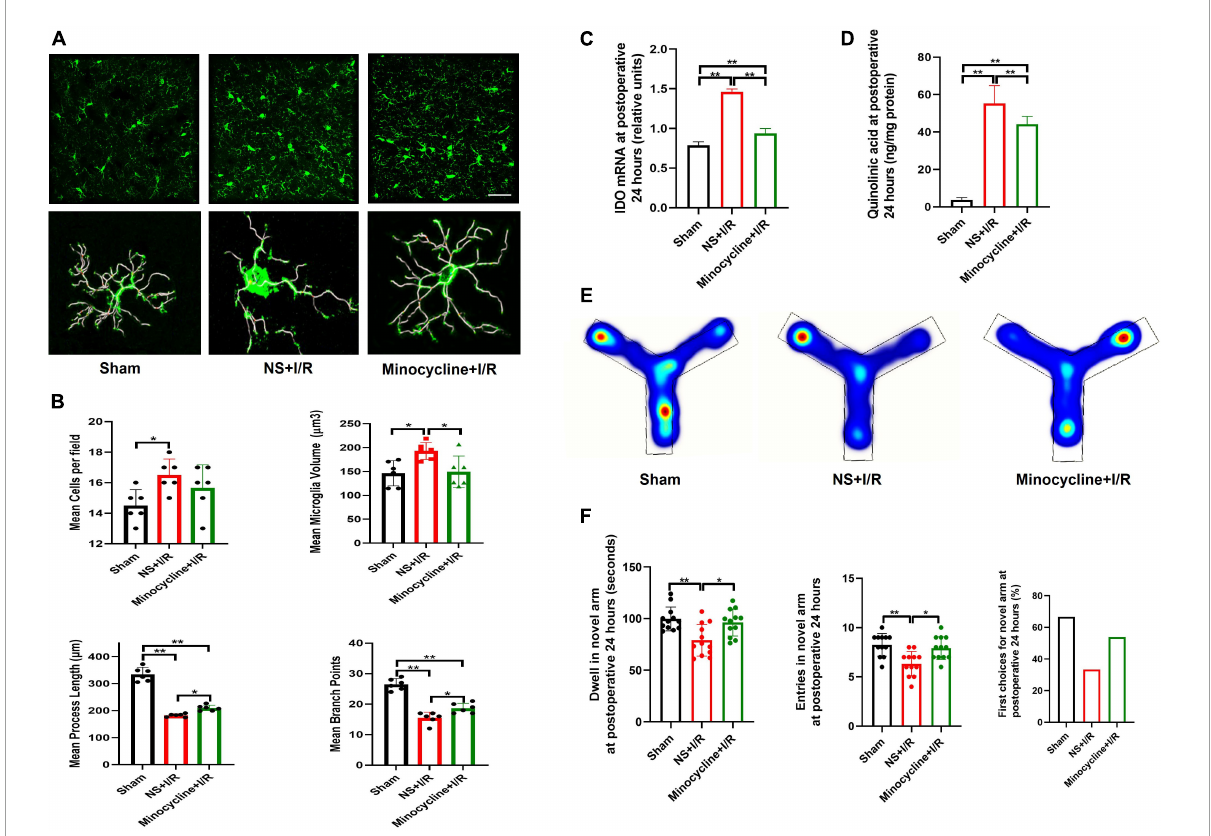
FIGURE4 Microglia reactivation and IDO-1/QUIN in BLA inhibited by MINO improved the cognition in the model mice. (A) Immunofluorescence staining and skeleton of microglia. (B) Analysis of microglia reactivation. (C) IDO-1 mRNA expression in BLA. (D) QUIN levels in BLA. (E) Heating map of Y Maze Test. (F) Results of Y Maze Test. N = 10–12 per group for Y maze testing, N = 8 for others, * P < 0.05, ** P < 0.01. I/R, ischemia and reperfusion; BLA, basolateral amygdala; NS, normal saline; MINO,